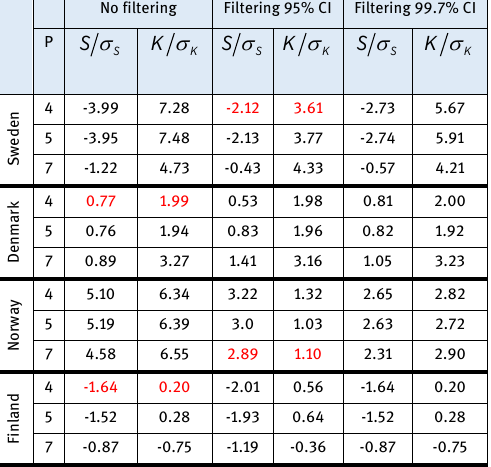
Table 5. Values of test statistic for skewness and kurtosis of the estimated residuals based on 4-, 5- and 7-parameter trend models of discrepancies before and after filtering, significant level of the significant test is 0.05. The column P shows number of parameters in each corrective surface model [unitless] No filtering